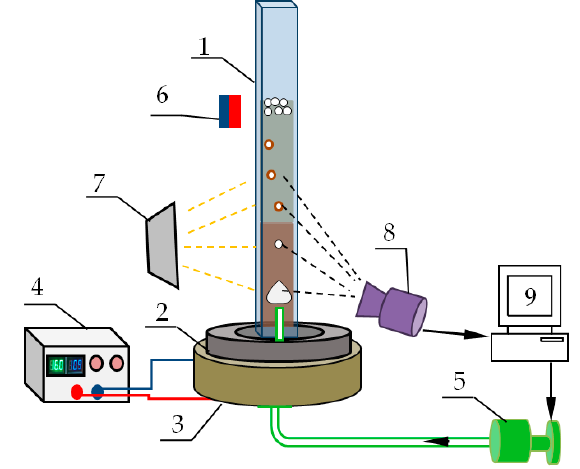
Figure 1. Experimental setup diagram. A flat glass channel 1 (2 mm thick), installed vertically using a non-magnetic fastener system, is filled with an MF sample. The top of it is filled with a layer of non-magnetic phase with the help of a syringe. An annular permanent magnet 2 (NdFeB 60 × 24 × 10 mm) placed on top of electromagnet 3 is used as a source of an inhomogeneous magnetic field. Taken together, they form a combined magnetic field source, which is located coaxially with the channel axis and connected to a power source 4 to change the magnetic